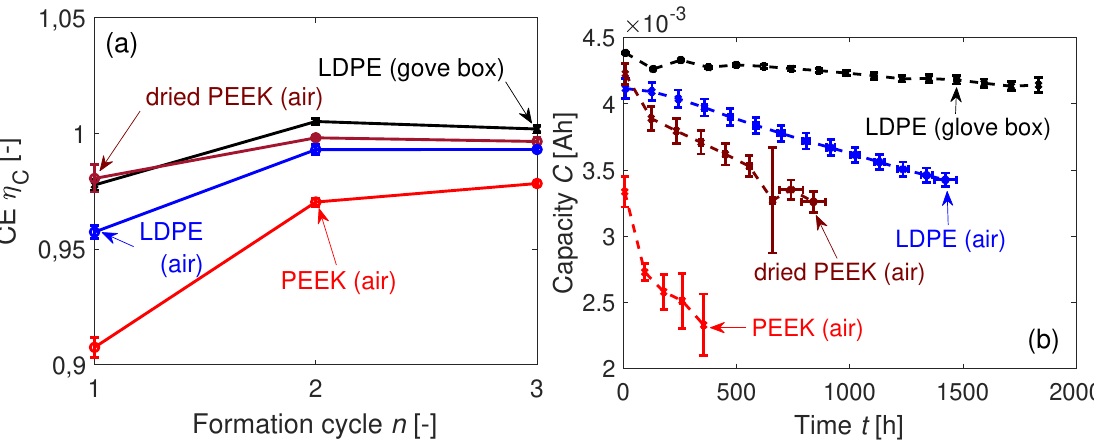
Figure 15. ( a ) Coulombic efficiencies CE of the coin cells during formation. ( b ) Mean capacities of the coin cells at T = 25 ◦ C with the LDPE sealing rings (not dried), PEEK rings (dried and not dried), and the coin cells with the LDPE sealing rings cycled in argon atmosphere (glove box) at room temperature.